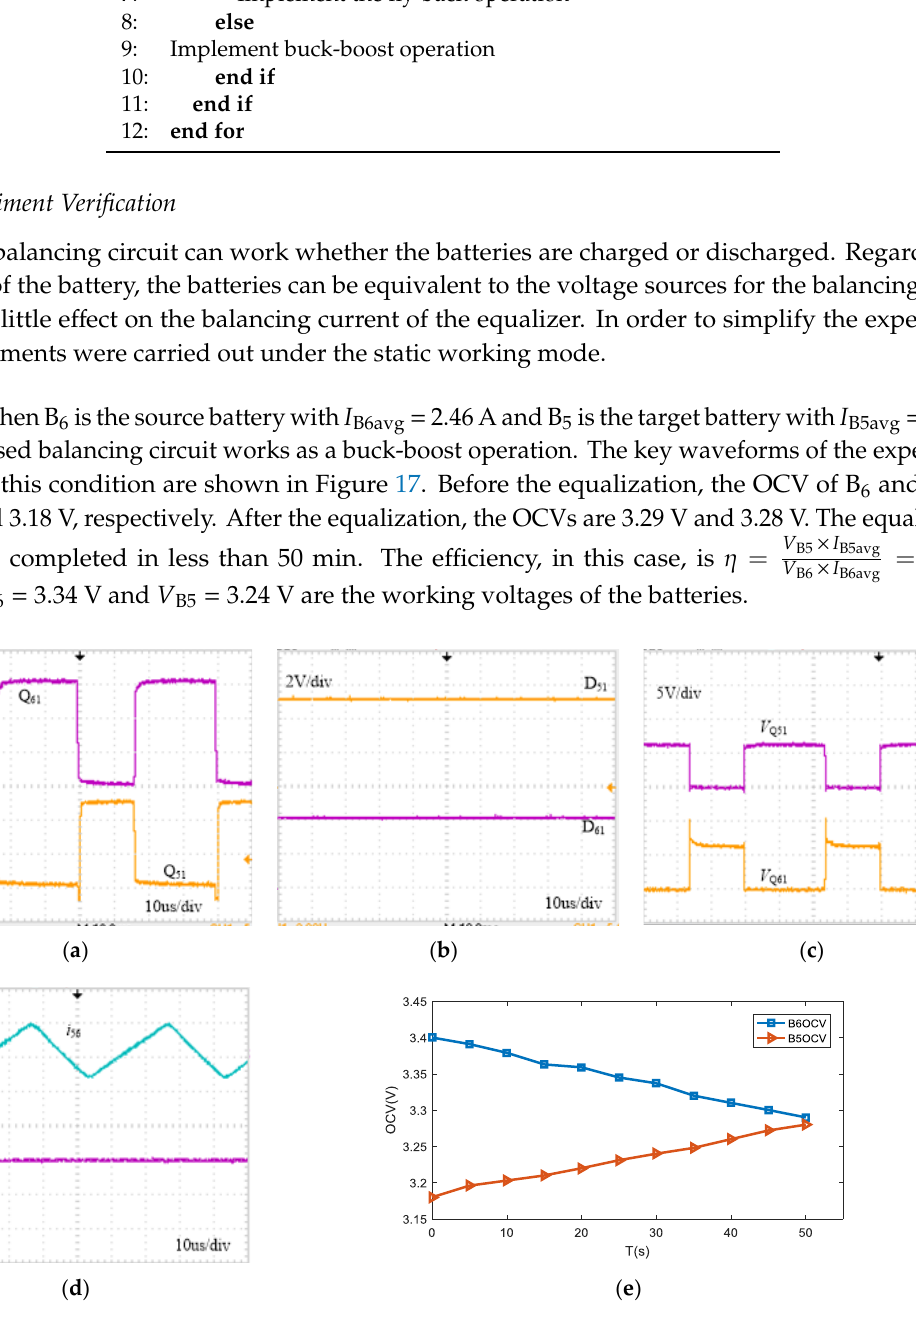
Figure 17. Key waveforms of Case 1: ( a ) driving signals of switches Q 61 and Q 51 ; ( b ) driving signals of switches D 61 and D 51 ; ( c ) voltages of switches Q 61 and Q 51 ; ( d ) current of the inductor i 56 ; and ( e ) static balancing curve.